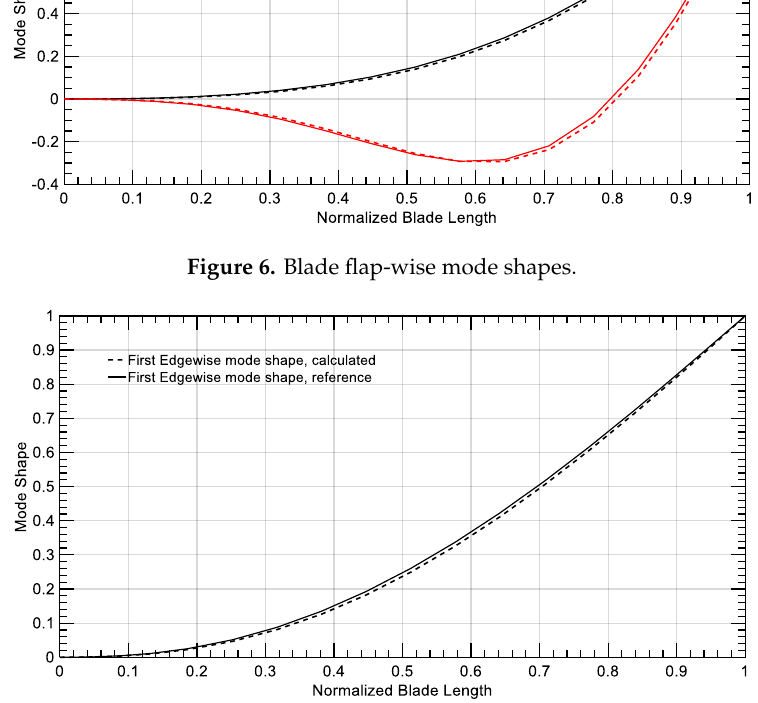
Figure 7. Blade edge-wise mode shape.